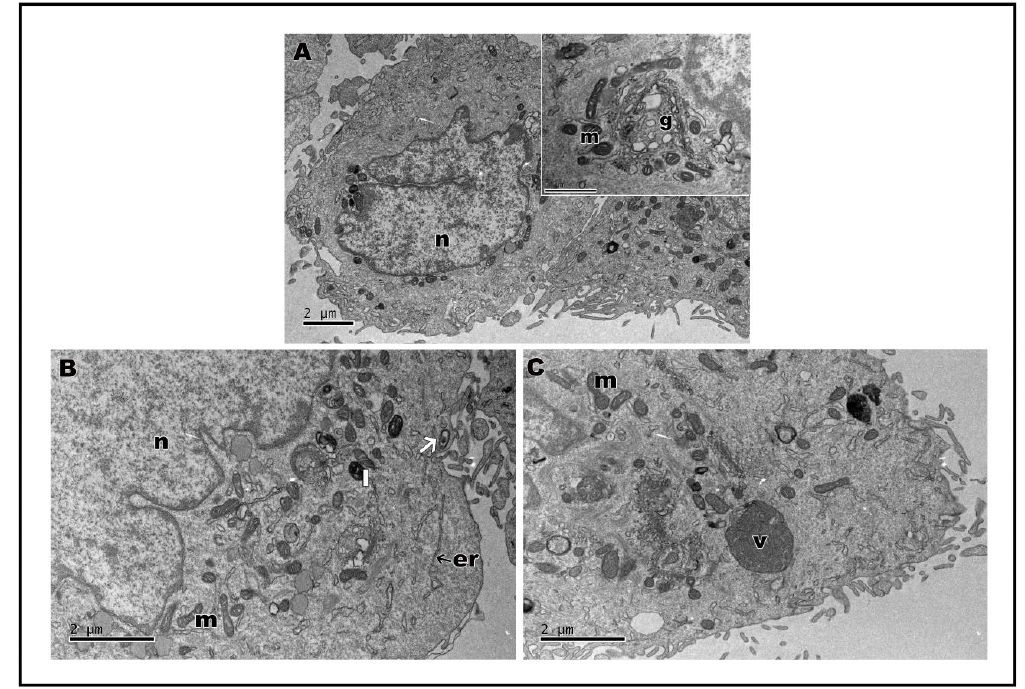
Figure 5. Transmission electron microscopy of HaCaT cells. Control cells ( A ); insect cytoplasmic region showing the Golgi complex. After treatment, for 24 h, with 5 µg/mL of nanoLPG ( B ) or LPG ( C ). (m) mitochondria, (n) nucleus, (g) Golgi complex, (er) endoplasmic reticulum, (l) lysosome, (v) autophagy vacuole, and (arrow) vesicle with nanoLPG.